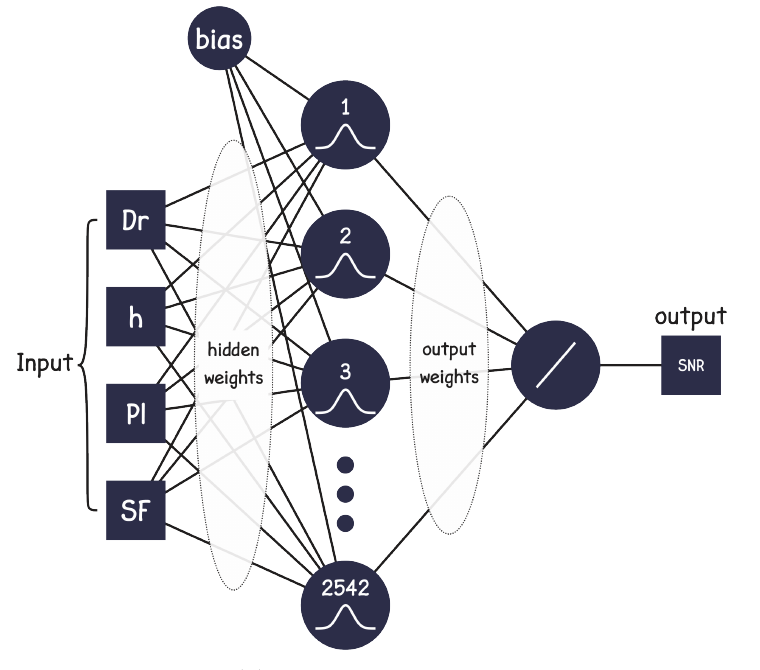
Figure 10. GRNN model.